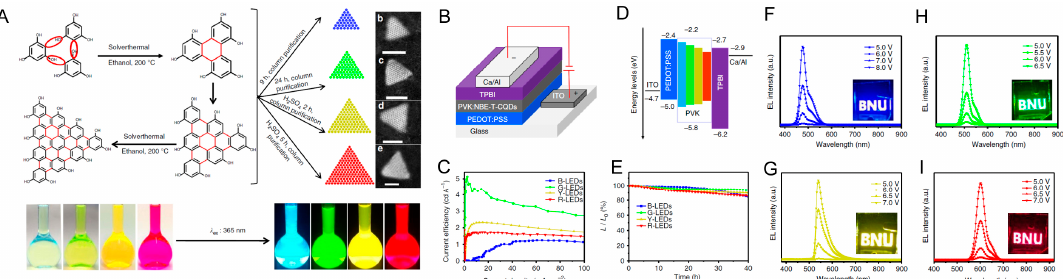
Figure 18. ( A ) Synthesis route of the T-CQDs by solvothermal treatment of PG triangulogen, with photographs of the T-CQD ethanol solution under daylight (left) and fluorescence images under UV light (excited at 365 nm) (right) included; ( B ) the device structure; ( C ) the current efficiency versus current density; ( D ) the energy level diagram of the T-CQD-based LEDs; and ( E ) the stability plots of the B-, G-, Y-, and R-LED. EL spectra of the B- ( F ), G- ( H ), Y- ( G ), and R-LEDs ( I ) at different bias voltage, respectively (the insets are the operation photographs of the B-, G-, Y-, and R-LEDs with the logo of BNU). Reproduced with permission from Reference [78], copyright 2019 Springer Nature group.